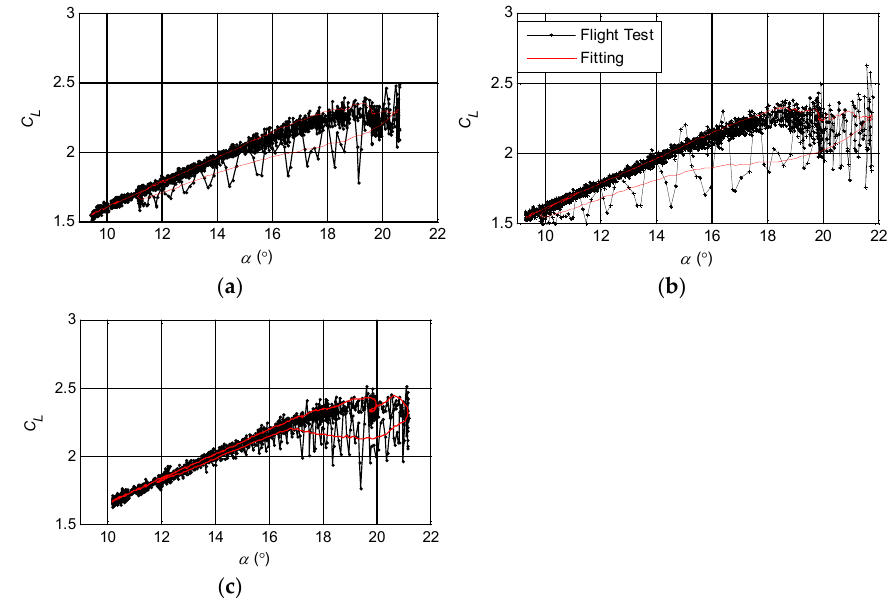
Figure 5. Lift coefficient fitting after optimization of stall aerodynamic parameters. ( a ) C L hysteresis curve for optimization of τ 1 and τ 2 ( α max = 21.8°); ( b ) C L hysteresis curve for optimization of τ 1 and τ 2 ( α max = 20.6°); ( c ) C L hysteresis curve for validation of τ 1 and τ 2 ( α max = 21.1°).